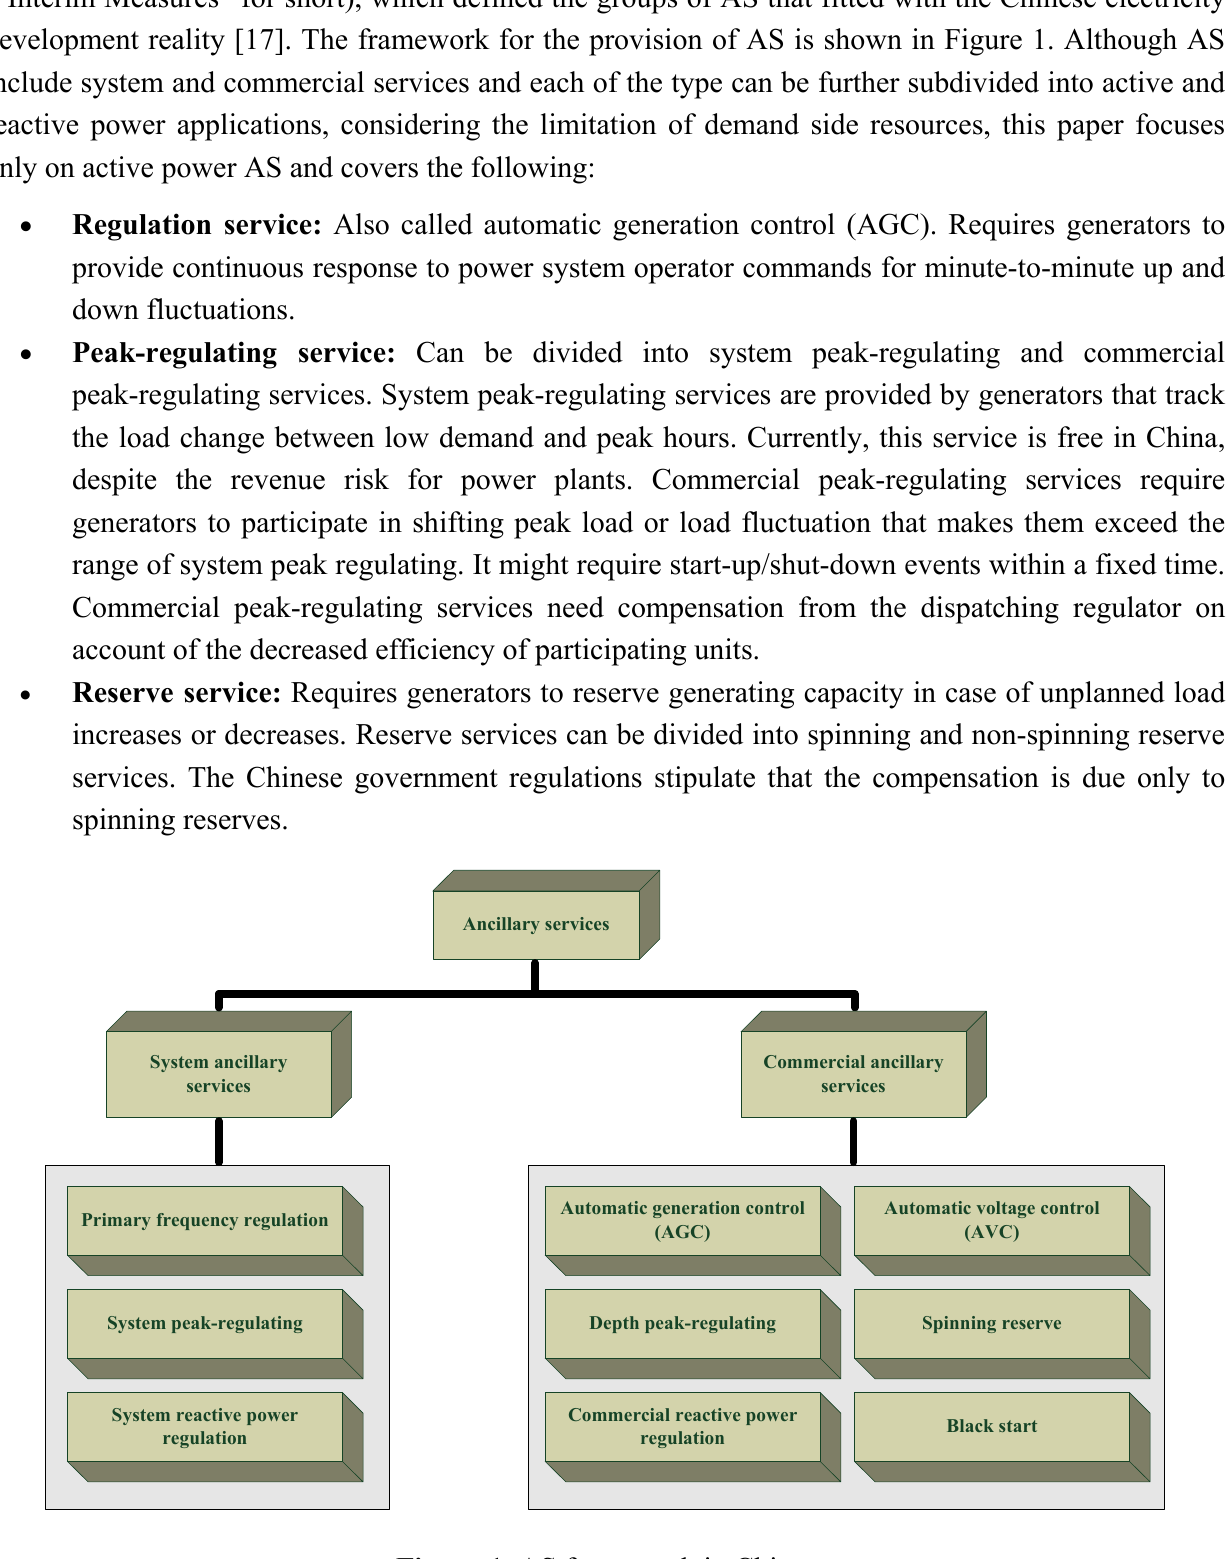
Figure 1. AS framework in